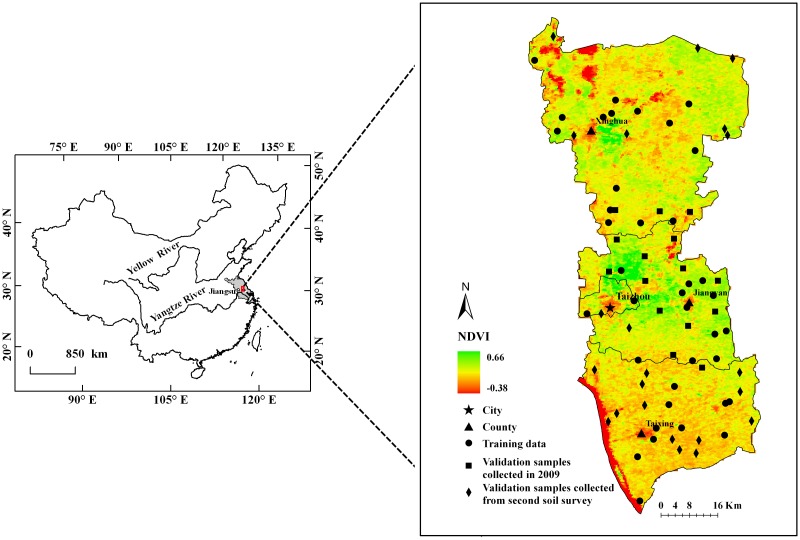
Location, sampling sites and NDVI distribution on DOY 324 in the year of 2007.NDVI: Normalized Difference Vegetation Index; DOY: Day of Year.